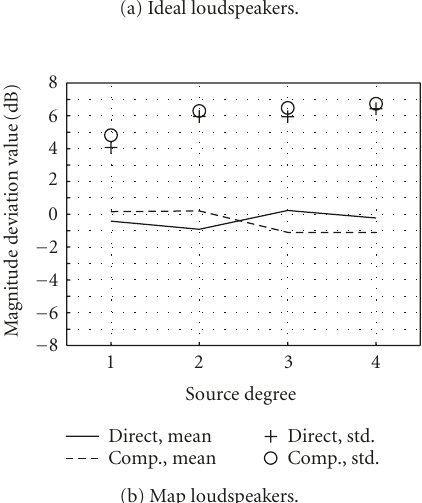
Figure 15: Mean value and standard deviation of MAG Ψ ated below the aliasing frequency for all microphone and source positions. Synthesis of rotated elementary directivity function (see (22)). Comparison between recomposition from elementary direc- tivity (comp) and direct synthesis (direct). All filters are calculated using individual equalization + average synthesis error compensa- tion